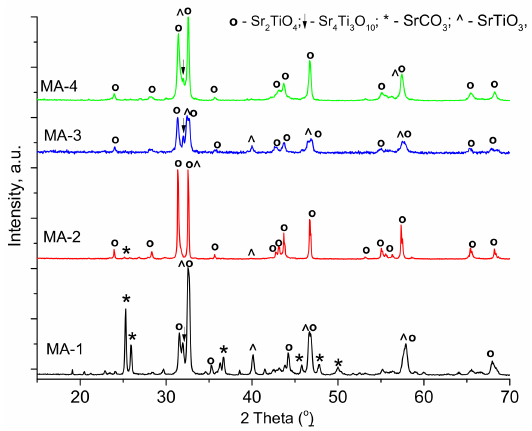
Figure 6. XRD patterns of the samples annealed at 900 ◦ C.